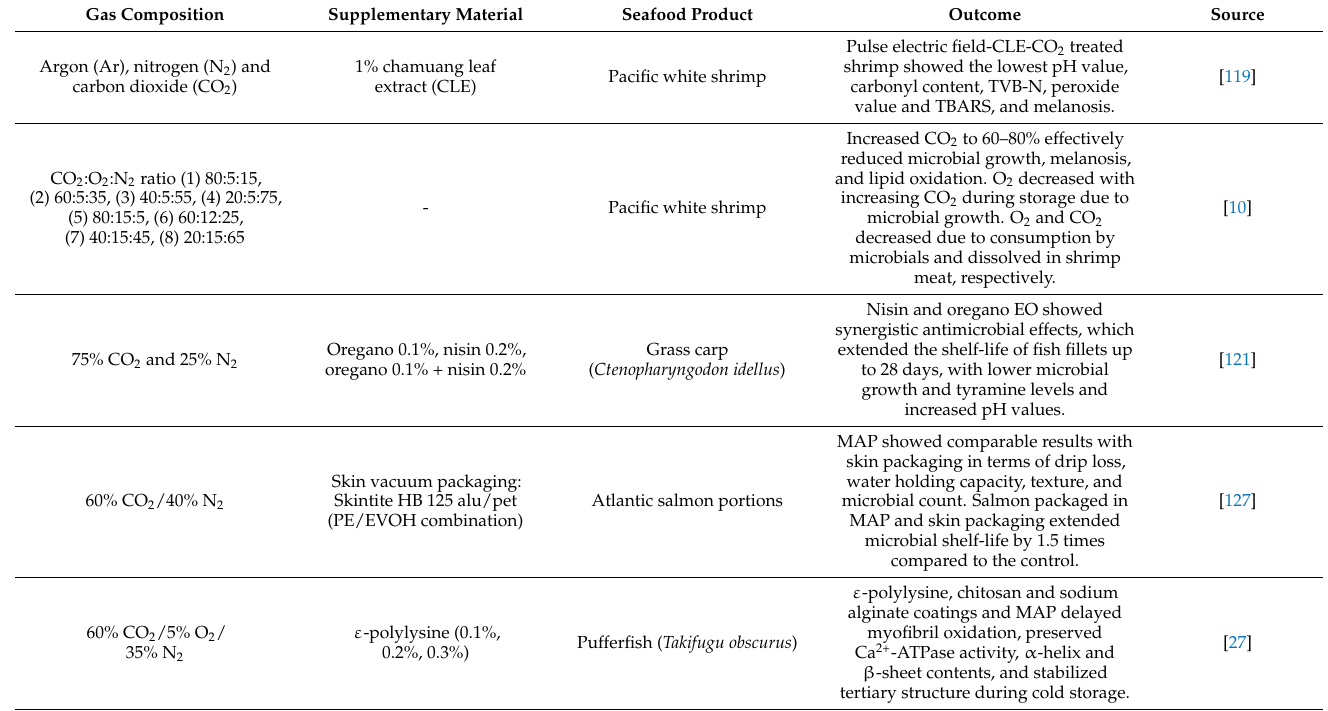
Table 3. Previous research on modified atmosphere packaging for seafood